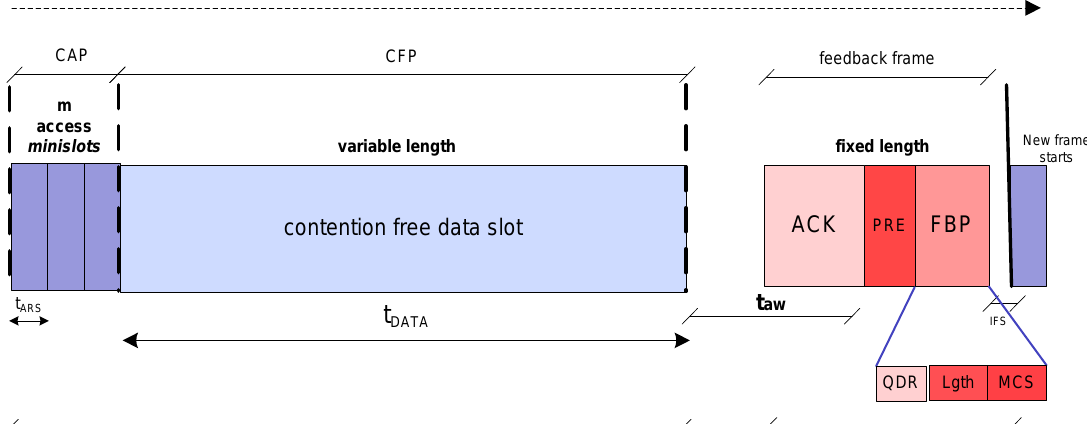
Figure 4. Energy-saving DQ MAC Superframe for